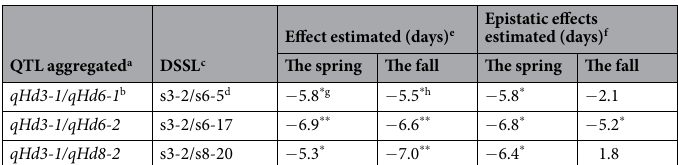
Table 4. Effects and epistatic effects estimated between QTL qHd3-1 and one of three QTLs, qHd6-1 , qHd6-2 and qHd8-2 , on heading date (HD) under the spring and the fall (days). a QTL aggregated denoted two target QTL that were used in aggregation. b QTL was nominated by qHd followed chromosomal number or -serial number. c DSSL (double substitution segment line) was developed from two SSSLs by MAS. d si-j represented jth SSSL on chromosome i . e Effect estimated was calculated by the genetic difference between DSSL and the control. f Epistatic effect estimated equaled to the effect of DSSL subtracted the sum of two SSSL effects. g The negative sign in the table indicated to shorten HD. h, * and ** denoted the significance at the 0.05 and 0.01 levels,